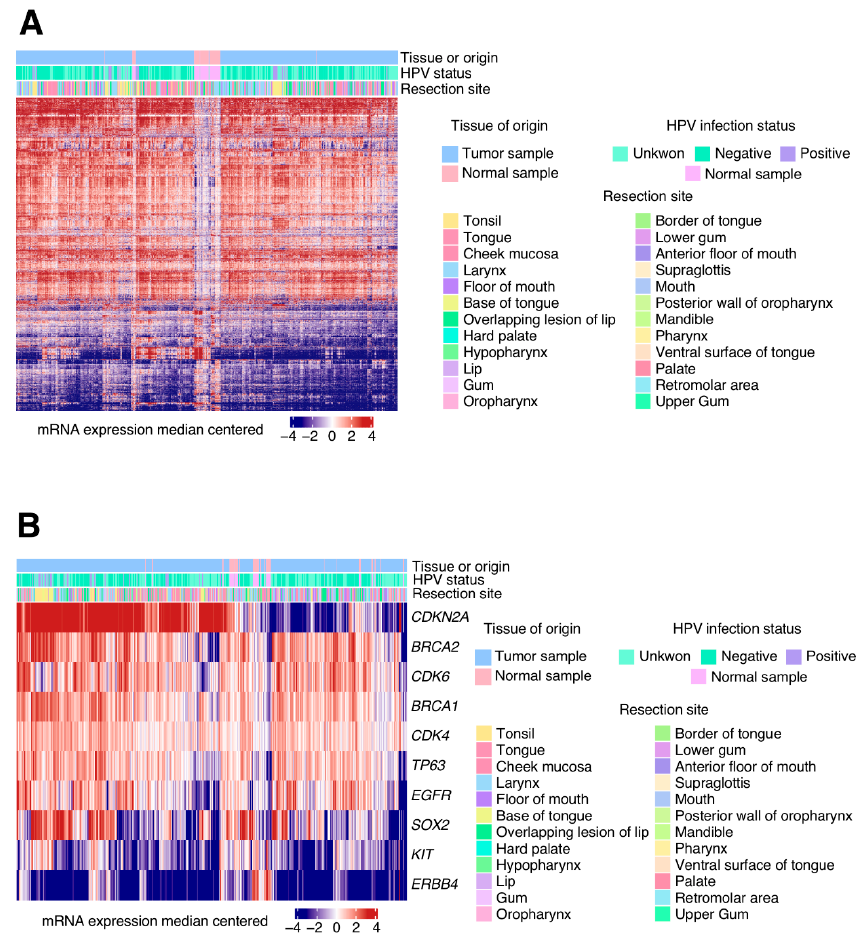
Figure 1. mRNA expression for each gene was computed into the Cancer Genome Atlas (TCGA)-head and neck squamous cell carcinomas (HNSCCs) tumour and normal samples. ( A ) Differentially expressed genes z-score heat map comparing the mRNA levels for tumours and normal samples. Hierarchical clustering shows the associations between the samples which share similar alteration patterns. This figure also shows information which makes an association between the human papillomavirus (HPV) infection status and the resection sites. ( B ) Heatmap of z -score for relevant genes involved in HNSCC pathogenesis that are differentially expressed between the normal and tumour samples. Clinical information has also been added to better differentiate altered patterns according to the HPV infection status or resection site.